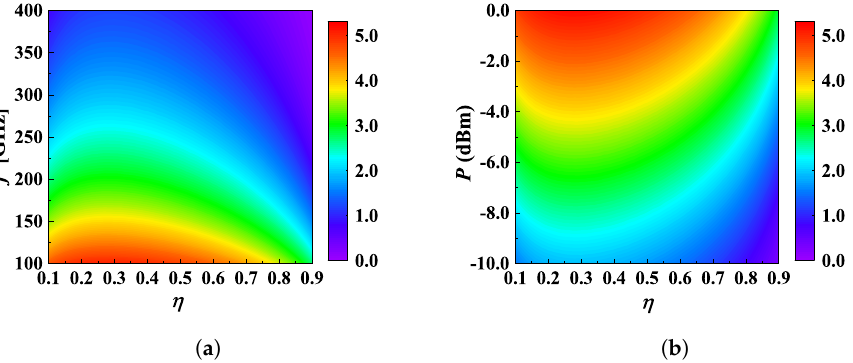
Figure 9. Secrecy performance in a non-colluding case. ( a ) The ECS as a function of η and f with P = − 10 dBm; ( b ) The ECS as a function of η and P with f = 300 GHz. Other parameters are given by: G = 25 dBi, N = 3, R S = 15 m, λ p =